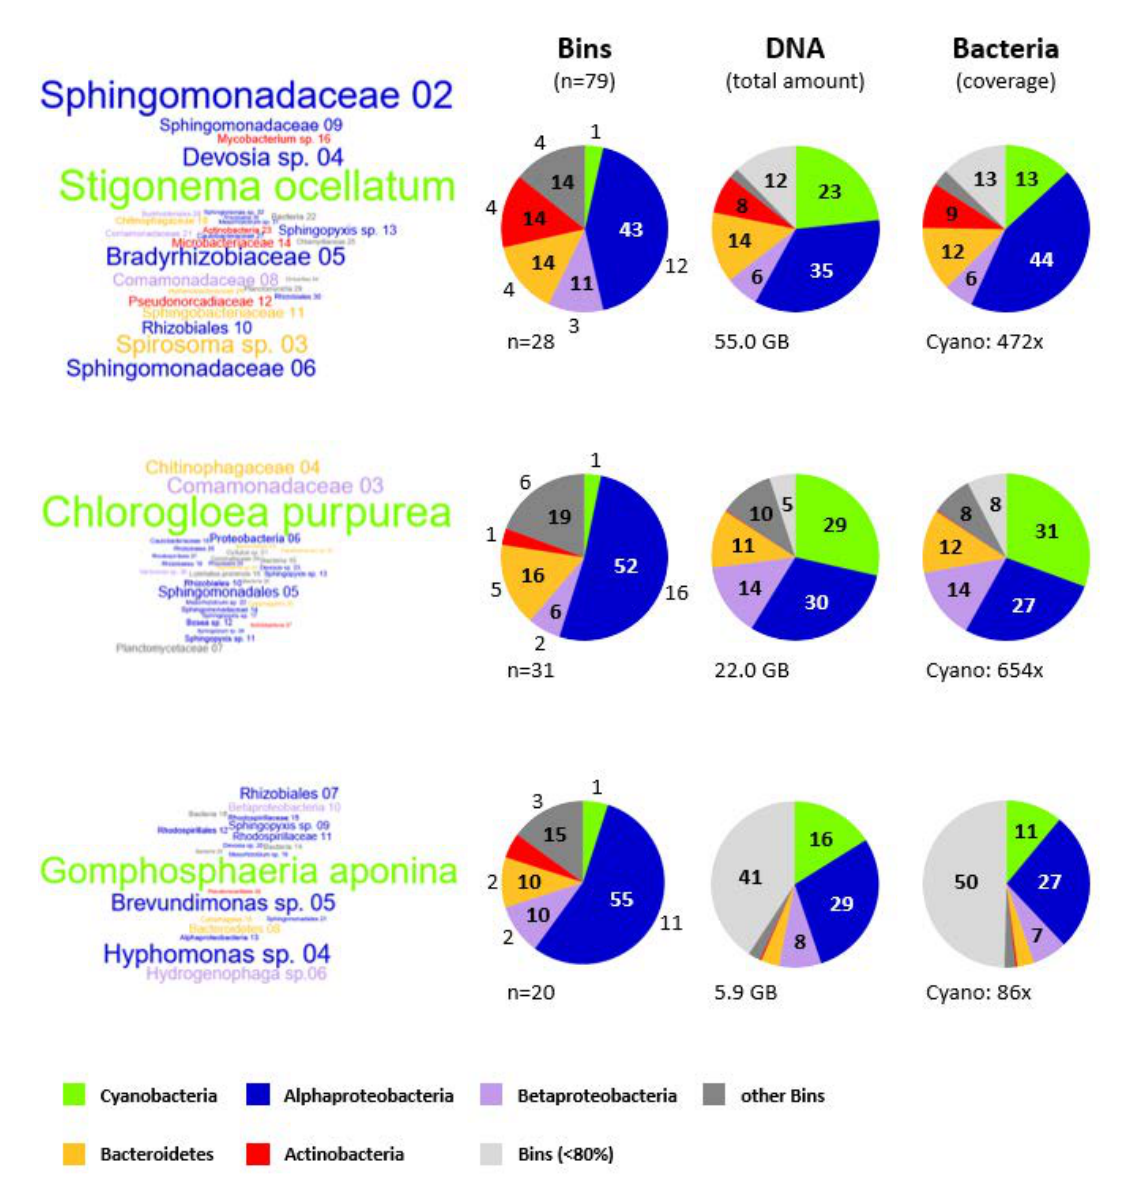
Figure 4. Relative abundance of bacterial bins in the cyanosphere of Stigonema ocellatum DSM 106950, Chlorogloea purpurea SAG 13.99 and Gomphosphaeria aponina DSM 107014. ( A ) Word clouds of metagenomic bins with a completeness of >80% (Table S5). The size of the taxon names corresponds to the genome coverage of the respective bins. The following color code was used to distinguish between the most abundant lineages on phylum/class level: green— Cyanobacteria , blue— Alphaproteobacteria , purple— Betaproteobacteria , orange— Bacteroidetes , red— Actinobacteria , dark gray—other bins, light gray—bins with a coverage below 80%. ( B ) Pie charts displaying the proportion of the bacterial lineages in percent. (i) The left pie charts show the relative abundance of the bins. The total number of bins per pie slice is also indicated. (ii) The middle pie charts show the total amount of DNA per bacterial lineage. Metagenome sizes range from 5.9 to 55.0 billion base pairs (Gbp). (iii) The right pie charts show the relative genome coverage of each category. The total genome coverage of the pivotal cyanobacterium is also shown.